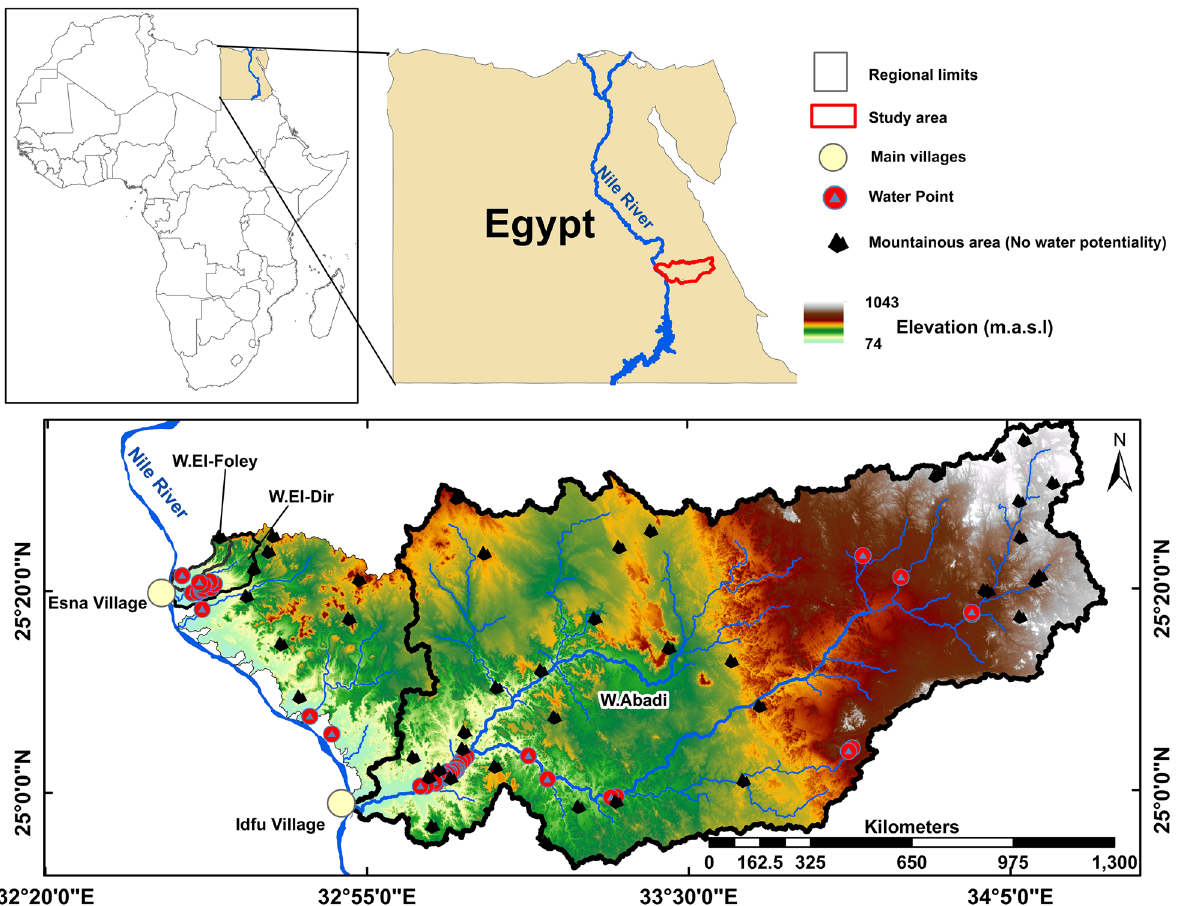
Fig. 1 General map of Egypt shows the geographic location of the study area and a close-up view of SRTM DEM illustrates wadis dissecting the study area trending east–west direction associated with the location of water points and mountainous